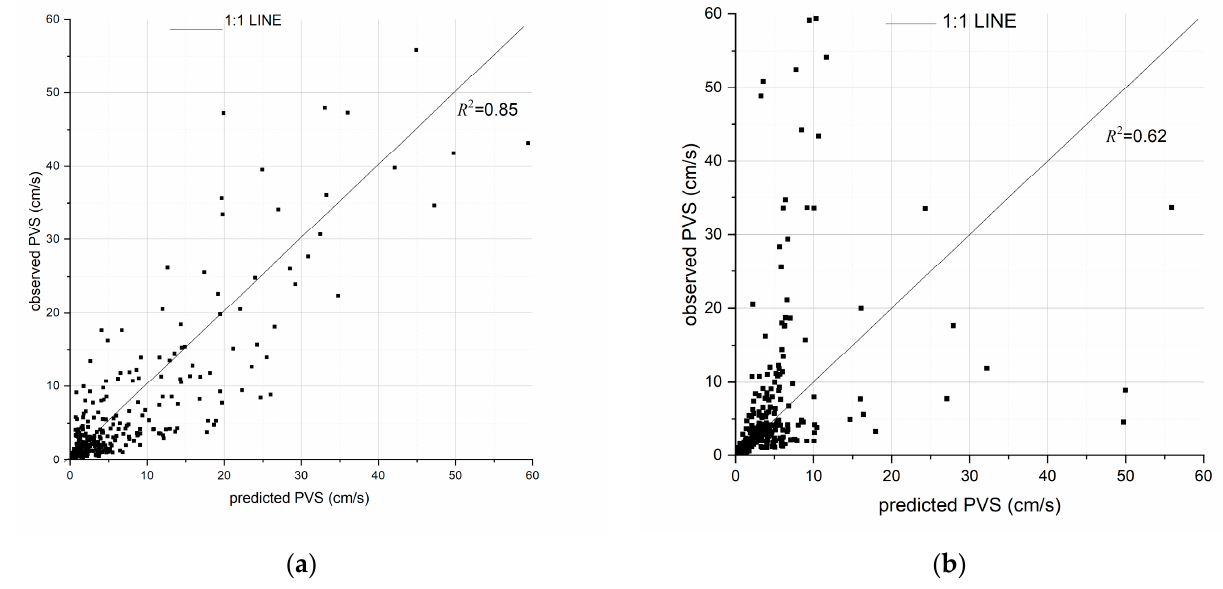
Figure 7. Predicted versus observed values of PVS: ( a ) new approach; ( b ) Sadovsky formula. As shown in the above comparison, when the vibration velocity value is small (<10 cm/s), the predicted results of the Sadovsky formula and the new method show good convergence. When the vibration velocity value gradually increases (>10 cm/s), the deviation of the Sadovsky formula prediction results increases rapidly, reaching a maximum of 6 times, while more than 90% of the prediction deviation of the new method remains within 1.3